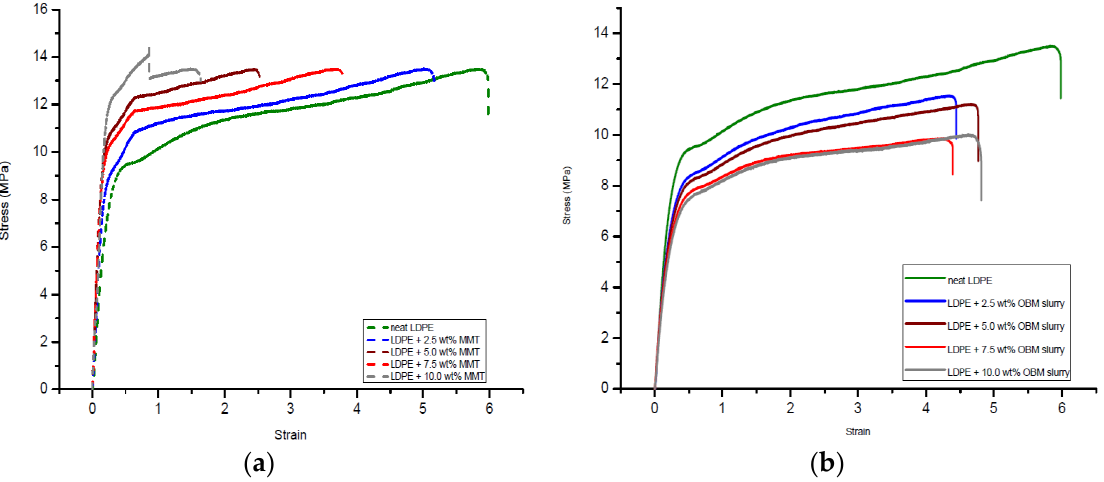
Figure 8. Stress–strain curves of ( a ) neat LDPE and LDPE/MMT and ( b ) neat LDPE and LDPE/OBM slurry nanocomposites.